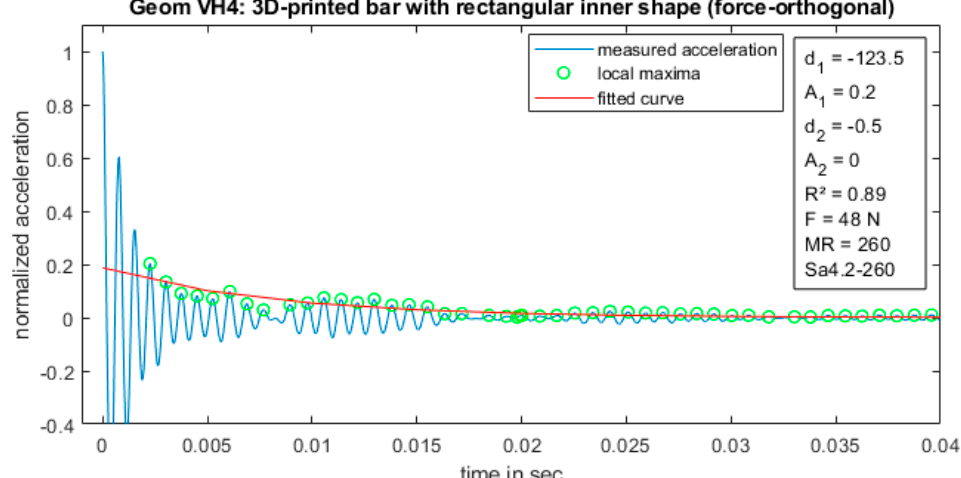
Figure 9. Acceleration data and fitted curve for a printed bar with a rectangular inner shape (force-orthogonal).